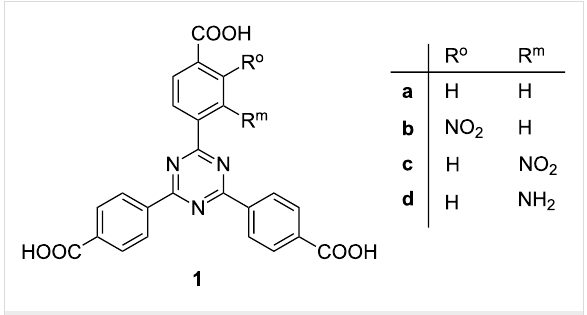
Figure 2: Mono-substituted TATB linkers 1b–d were successfully em- ployed in the isoreticular syntheses of PCN-6 MOFs [10].